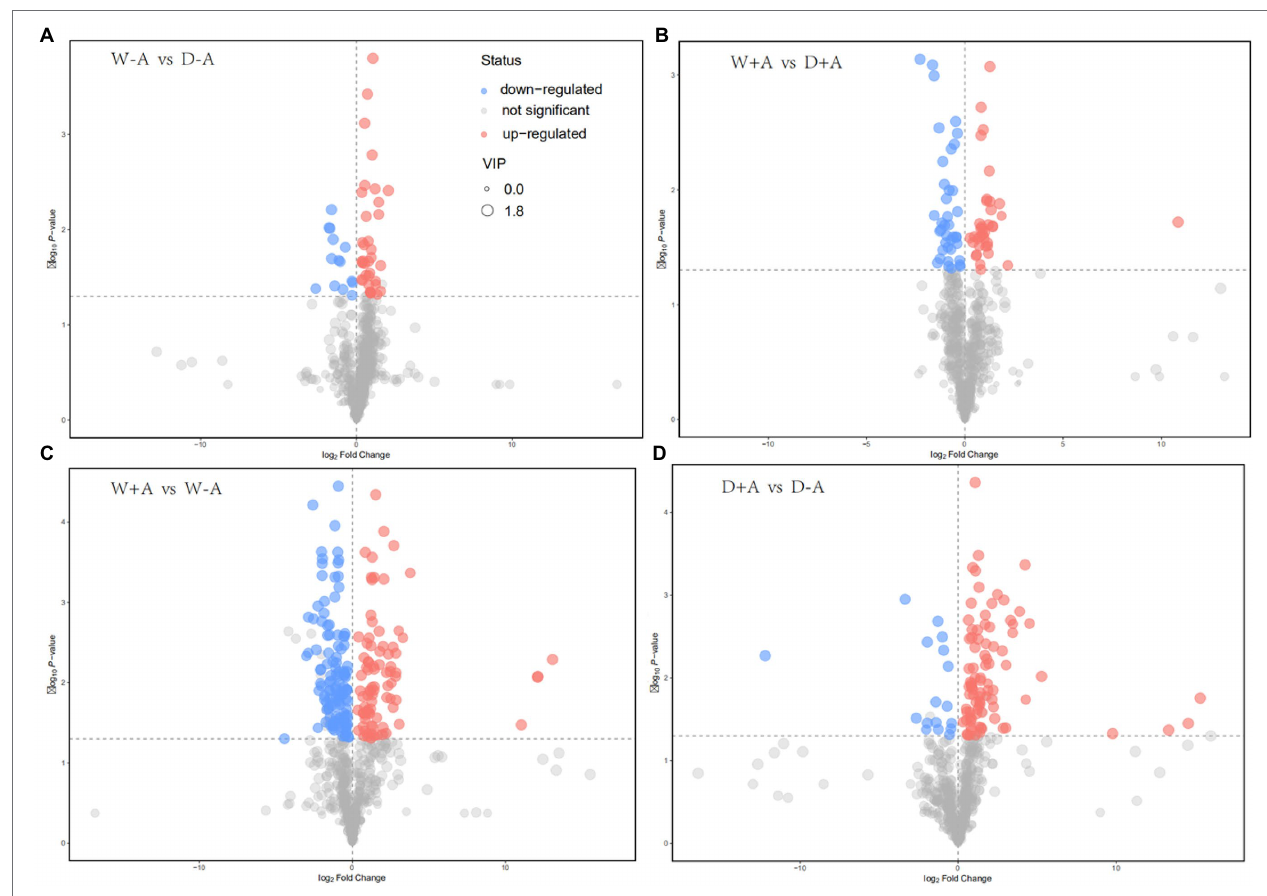
FIGURE 4 | Volcanic map of different metabolites in roots of trifoliate orange seedlings under well-watered and drought stress conditions after inoculation with Rhizophagus intraradices . Abbreviation: W + A, inoculation with R . intraradices under well-watered conditions; W-A, inoculation without R . intraradices under well- watered conditions; D + A, inoculation with R . intraradices under drought stress conditions; D-A, inoculation without R . intraradices under drought stress conditions; mix, quality control